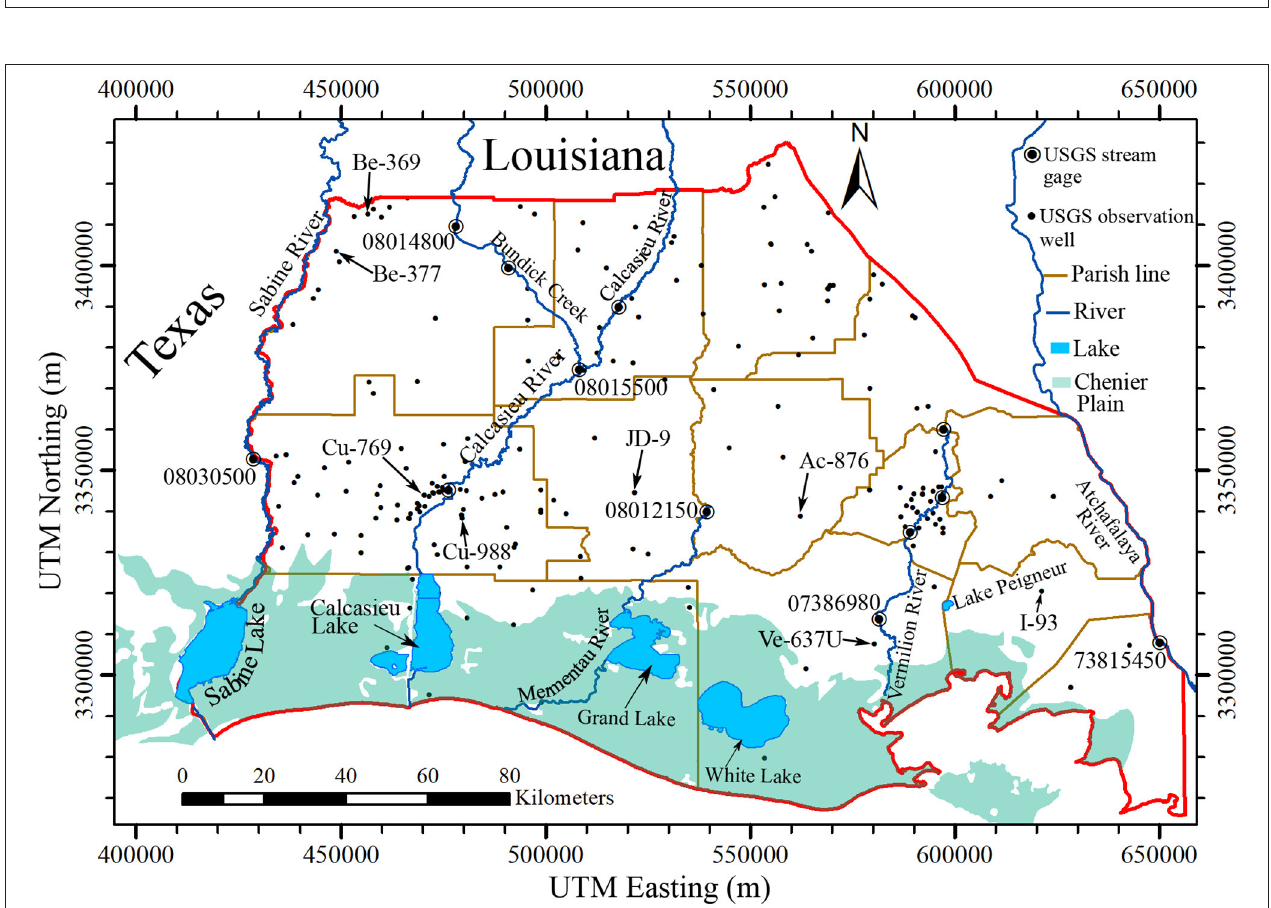
FIGURE 5 | Locations of USGS stream gages and groundwater observation wells. Measured and simulated groundwater levels in the wells with well name are shown in Supplementary Figure 1 .